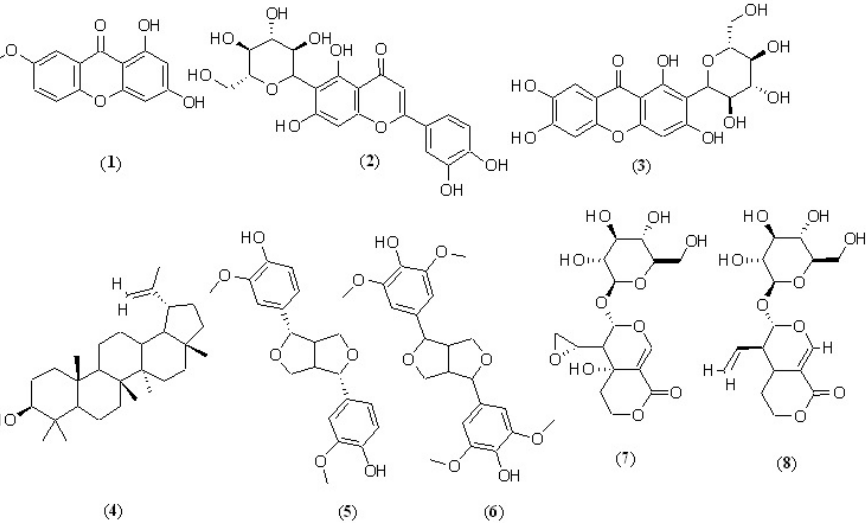
Figure 1. Candidate Gentian compounds with skin regeneration and wound-healing potential. isogentisin ( 1 ), isoorientin ( 2 ), mangiferin ( 3 ), lupeol ( 4 ), pinoresinol ( 5 ), syringaresinol ( 6 ), eustomoside ( 7 ), and sweroside ( 8 ). Table 2. Some of the most important compounds in seven European and Asia Minor Gentiana species (Gentiana lutea, G. punctata, G. asclepiadea, G. septemfida cruciata, G. oliverii, and G. gelida ), which were found to be used in relation to wound-healing practices in traditional medicine (see Table 1). Legend: This compound is of uncertain origin and is rather an artifact of the extraction